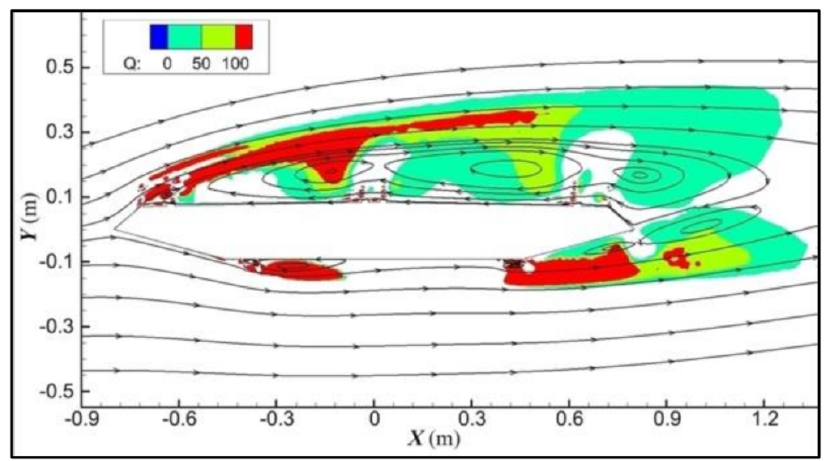
Figure 4. Contours of time-averaged vortex structures at stationary case.